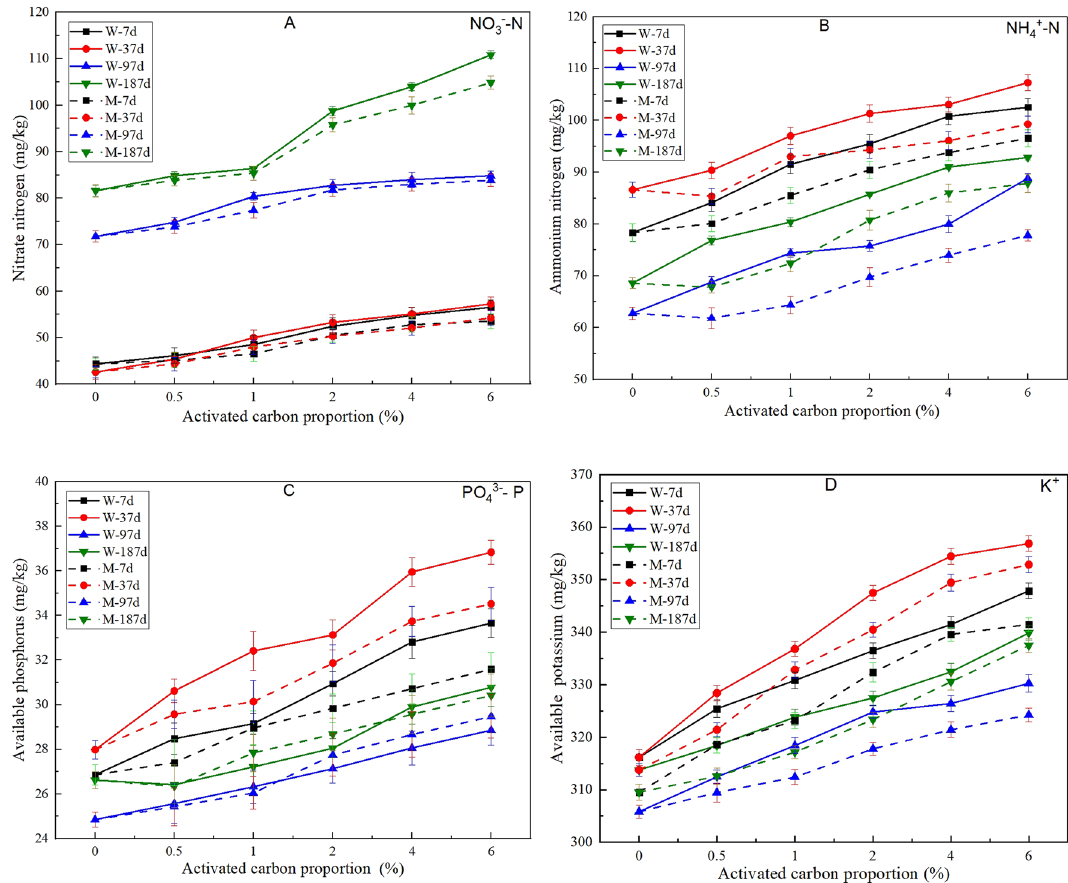
Figure 8. Effect of activated carbon on the contents of nitrate nitrogen ( A ), ammonium nitrogen ( B ), available phosphorus ( C ) and available potassium ( D ) in vegetation